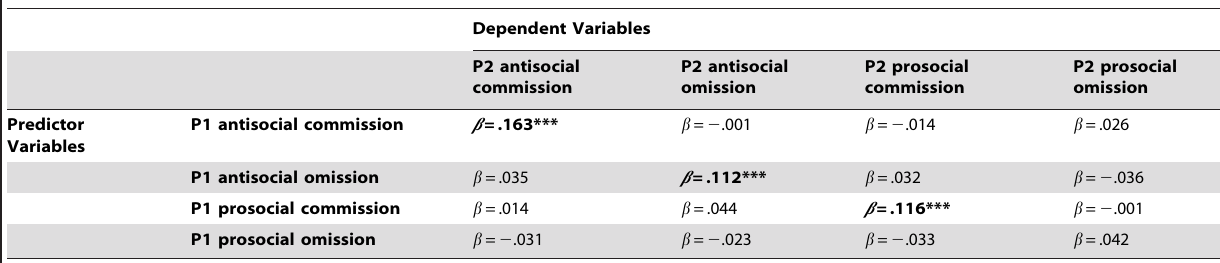
Table 3. Summary of Beta Values for Replication Regression Analyses.